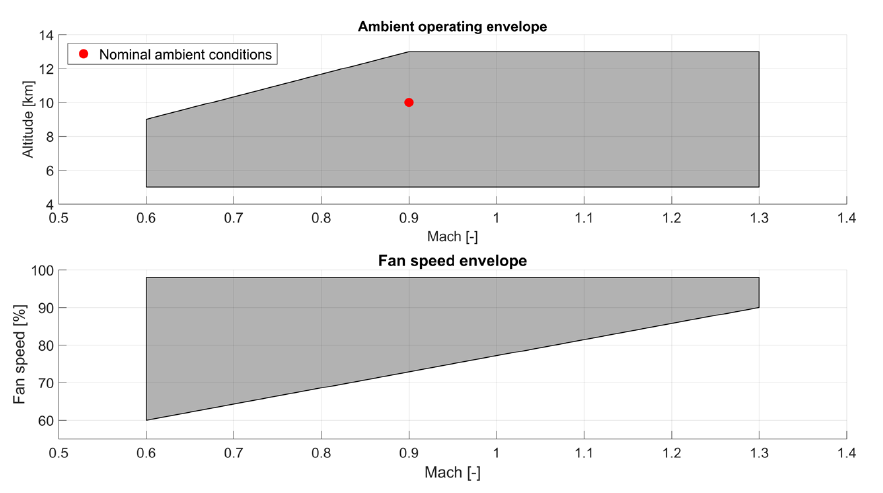
Figure 3. Operational envelop.